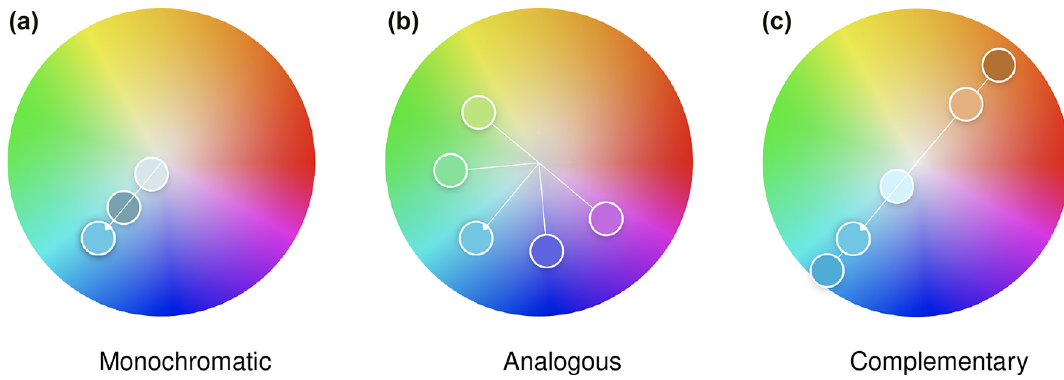
Figure 4: Three common color harmony rules with base color blue. Created in Adobe Color: